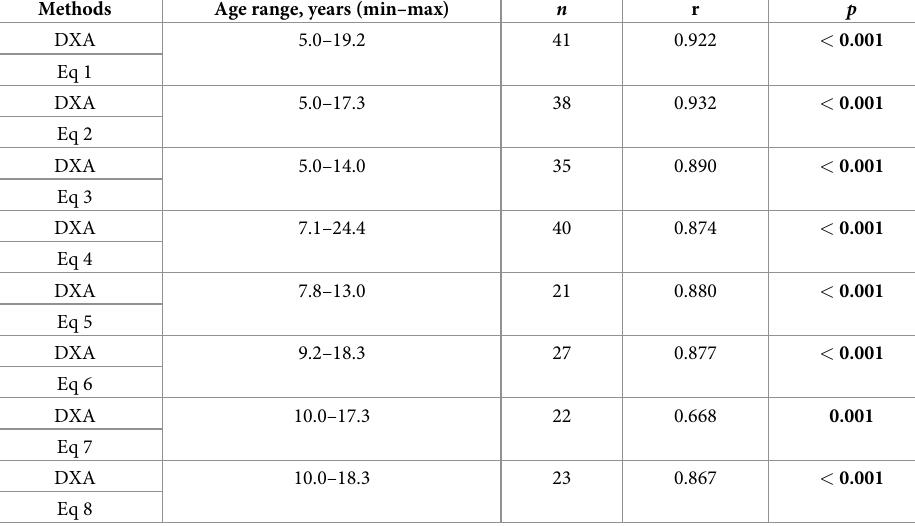
Table 3. Correlation (r) between the percentage of fat-free mass (%FFM) in boys with Duchenne muscular dystro- phy, estimated by predictive equations by bioelectrical impedance (Eq 1 –Eq 8) and determined by dual-energy X- ray absorptiometry (DXA).